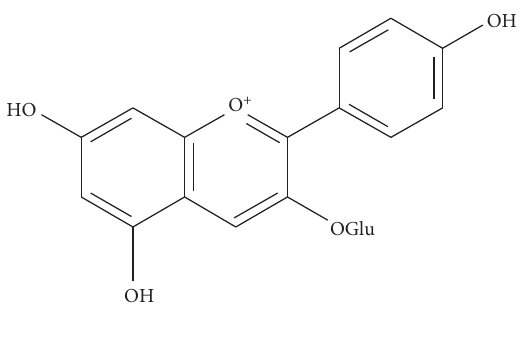
F 2: Structure of pelargonidin-3-glucoside.